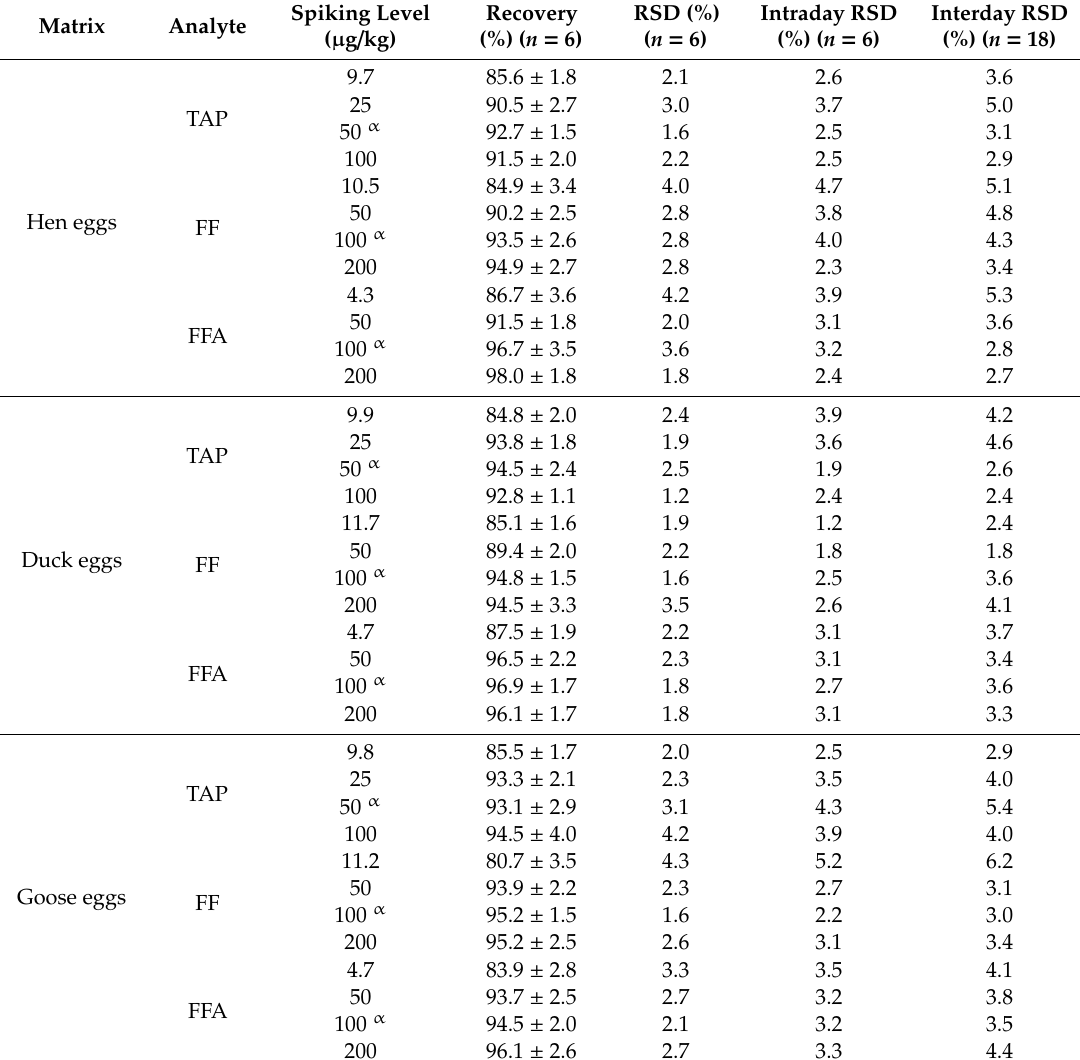
Table 4. Recoveries and precisions of TAP, FF and FFA from spiked blank hen eggs, duck eggs and goose